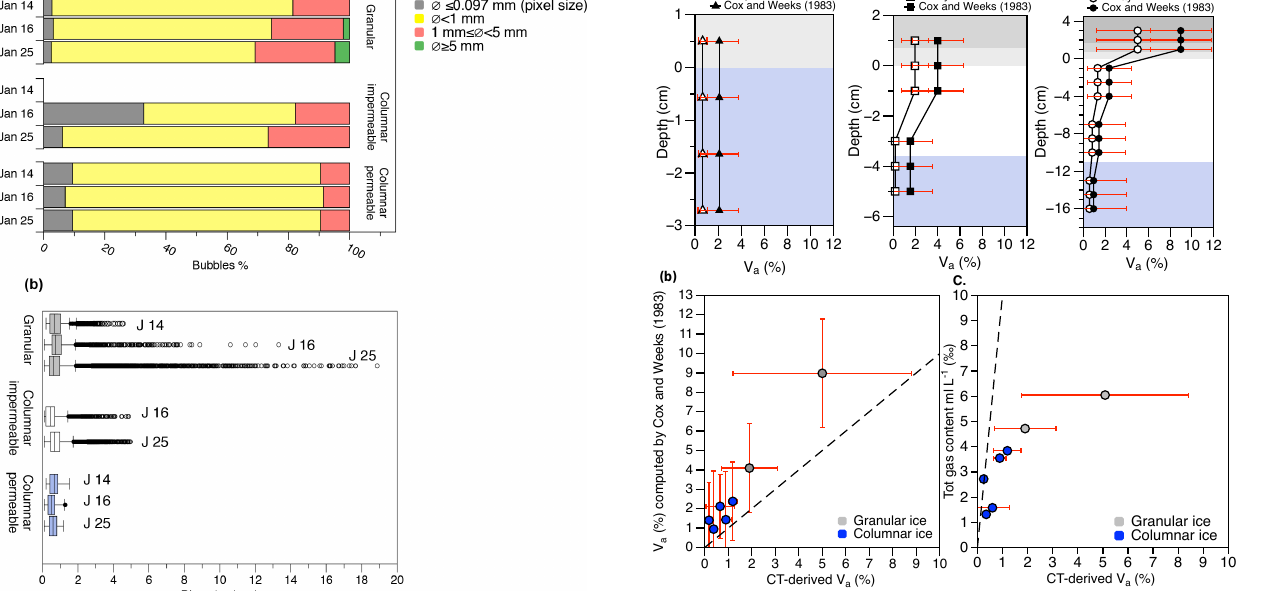
Figure 9. (a) The proportion of micro, large, and macro bubbles for each ice type and sampling date. (b) IQR box plot showing the dis- tribution of the bubble diameters, per ice type and sampling dates. The box is defined by the first and third quartiles of the distribution, the line in the box is the median, the circles represent the outliers (an outlier is any value that lies more than one and a half times the length of the box from either end of the box, T bars).